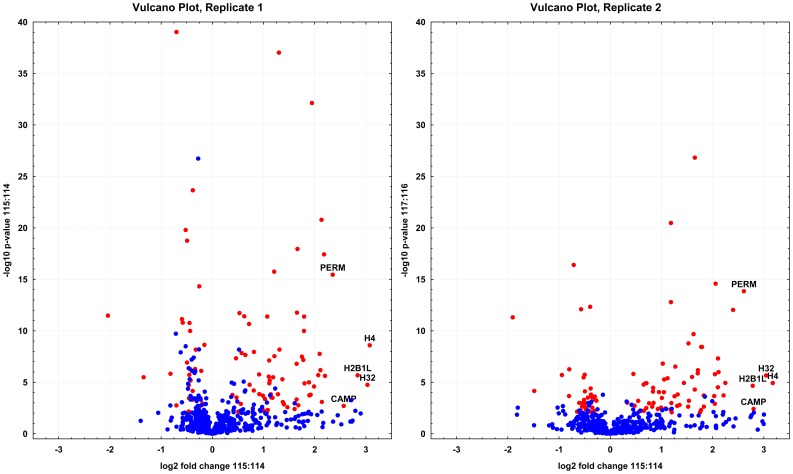
Volcano plots constructed from iTRAQ quantification data.The volcano plots show how much and how significantly proteins identified in the exploratory phase of the study using representative pooled samples were altered due to the presence of both MIAC and HCA. The top five proteins with the most profound change are highlighted by their abbreviated names (H4 - histone H4; H32 - histone H3.2; H2B1L - histone H2B type 1-L; CAMP – cathelicidine; PERM – myeloperoxidase). Proteins that were found significantly changed (p<0.01) in both replicates are coded in red.